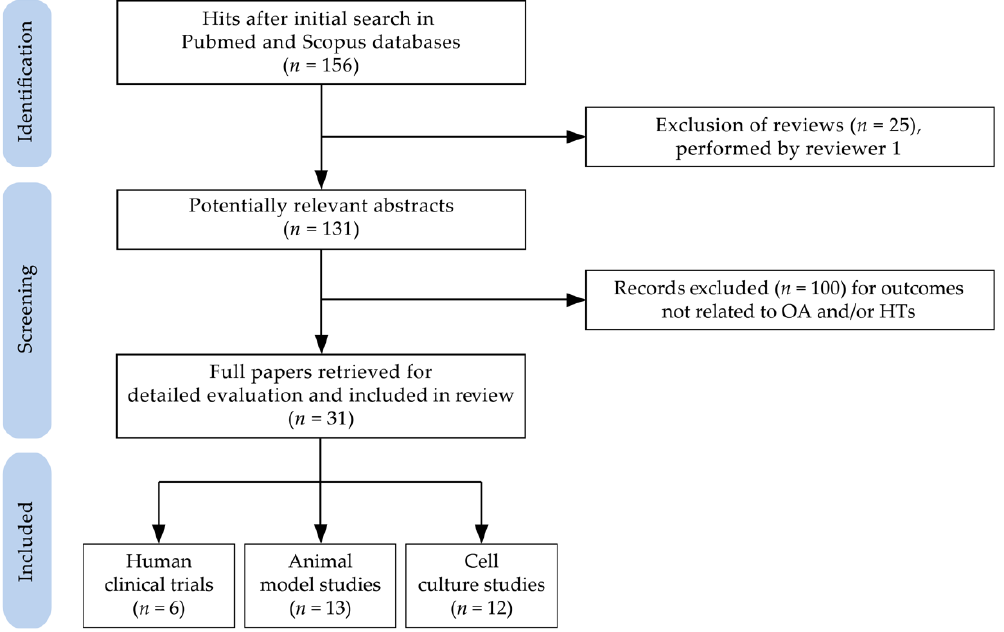
Figure 2. Flow chart of papers included in the review (Abbreviations: HTs: hydrolyzable tannins; OA: osteoarthritis).